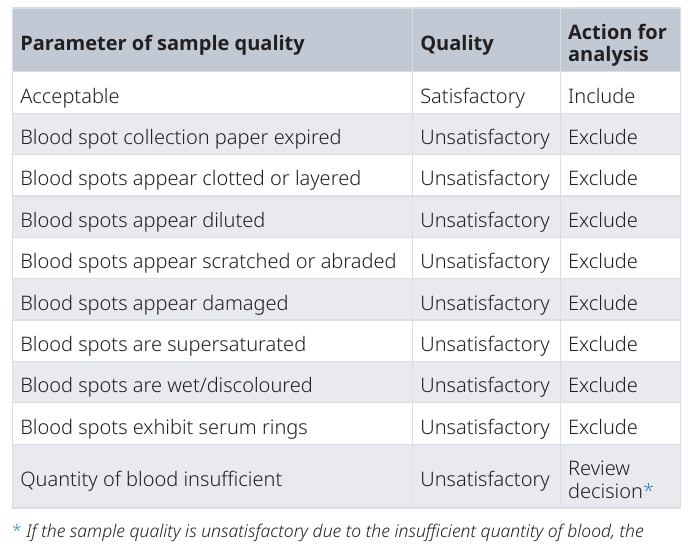
Table 2. Sample quality screening